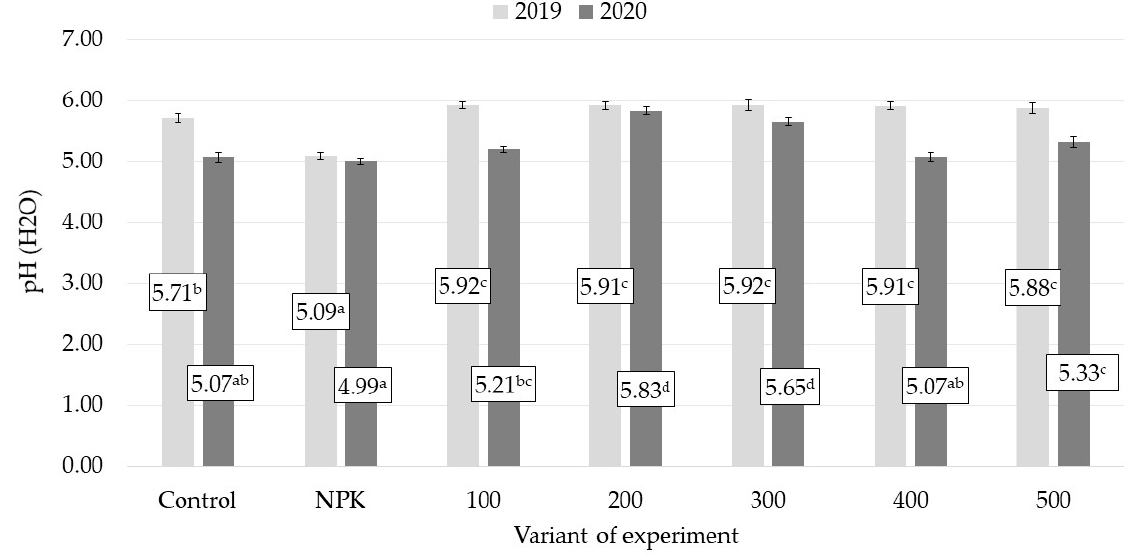
Figure 1. Changes in the pH value of the podzolic soil in the 0–5 cm layer after application of biomass combustion ashes (mean ± SD). Identical superscripts indicate that there are no significant ( p > 0.05) differences between the experimental variants, as shown by the Tukey HSD post hoc test.